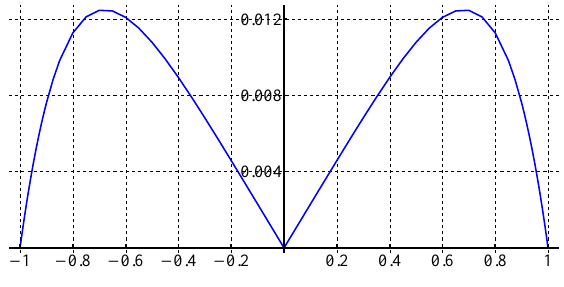
Figure 3: The difference j ρ j − ν ( X , Y ) for jointly normal X ,